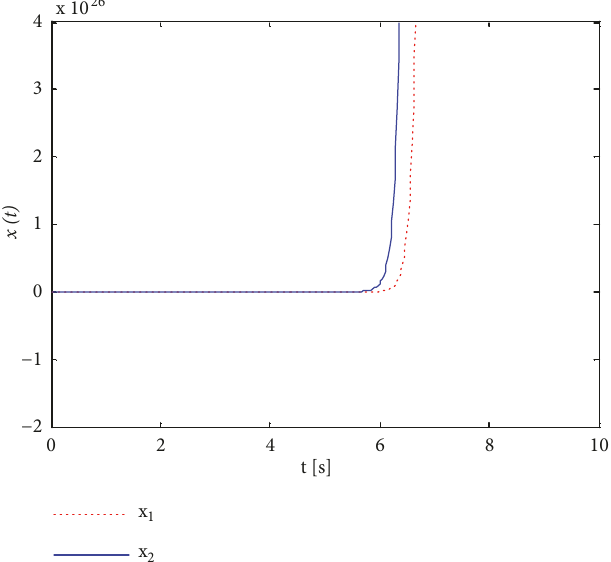
Figure 2: State response curve of closed-loop system under control of memoryless feedback controller.